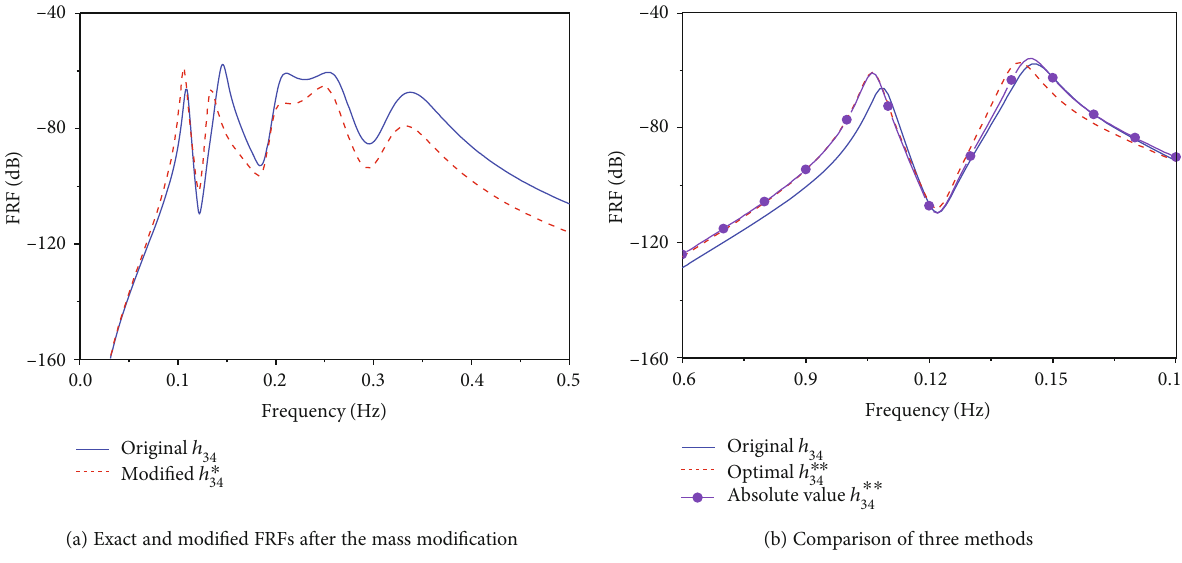
Figure 11: Comparison of FRFs between original and modi fi ed systems with modal damping ratio